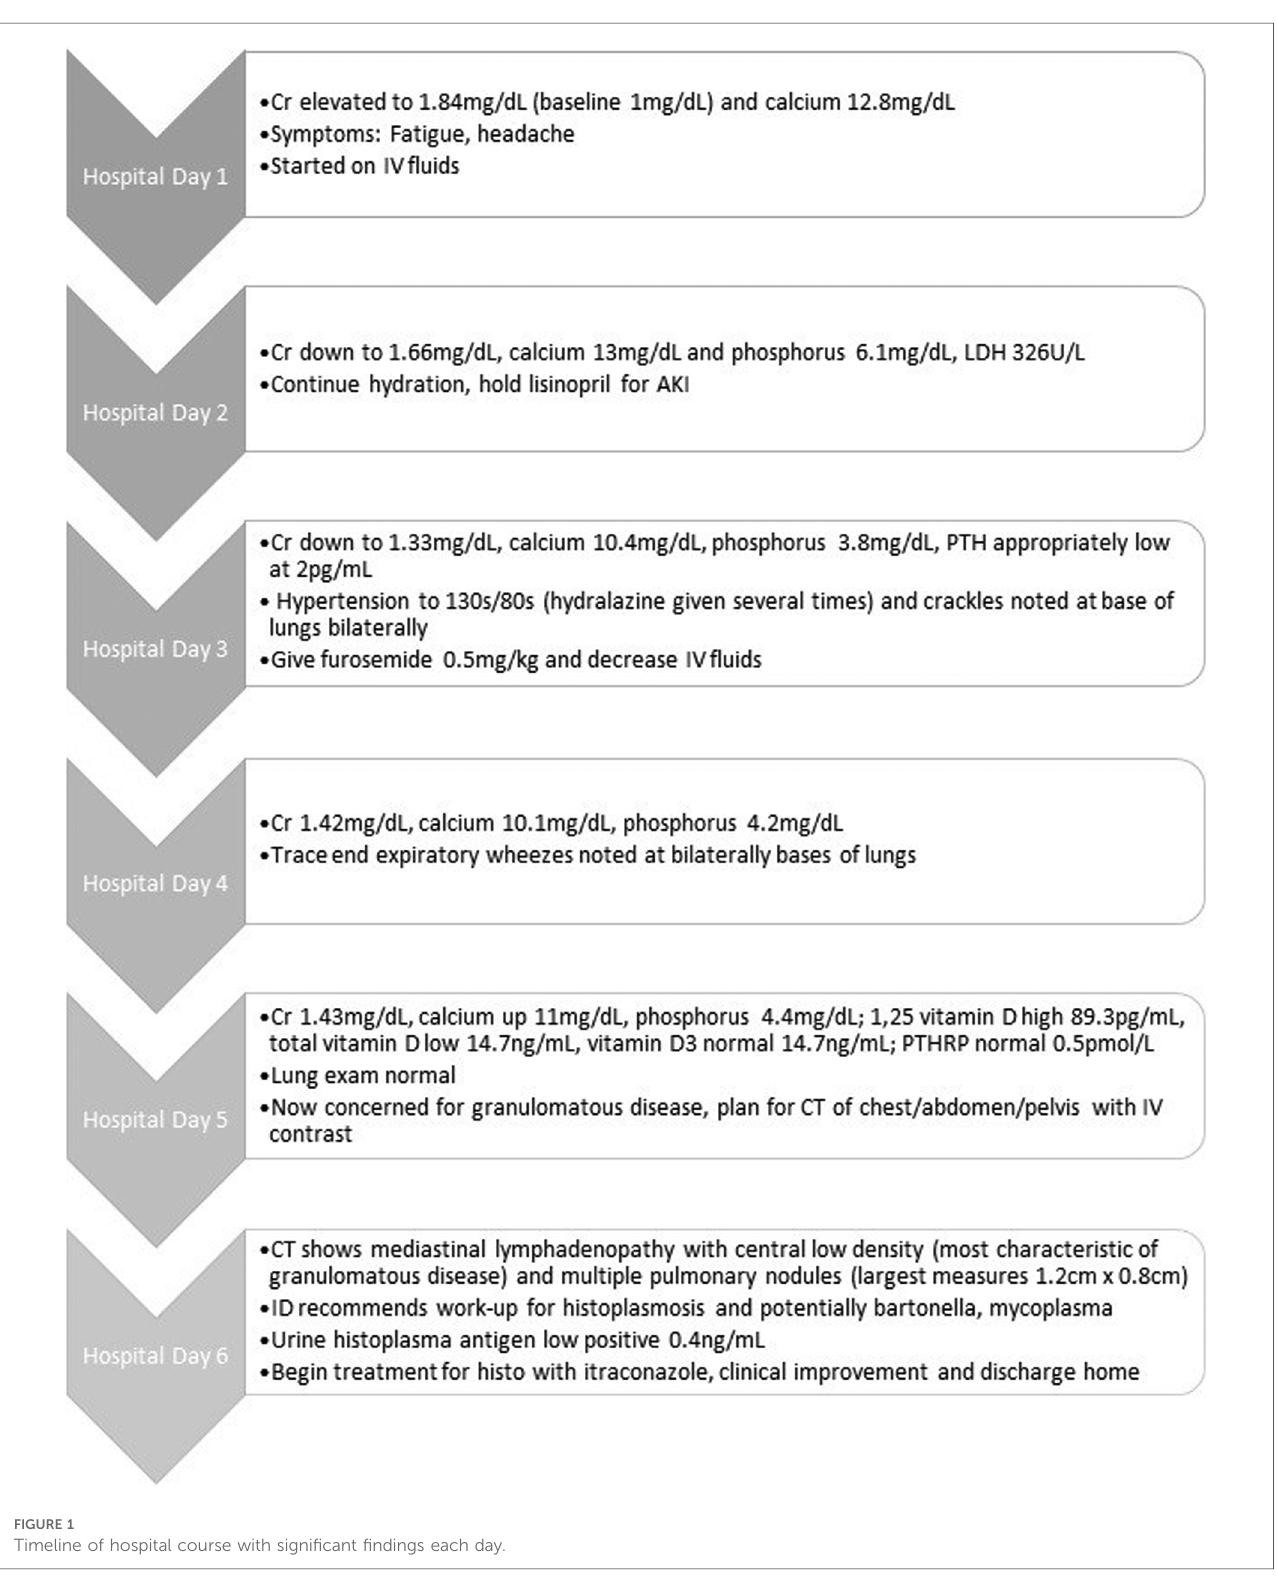
FIGURE 1 Timeline of hospital course with signi fi cant fi ndings each